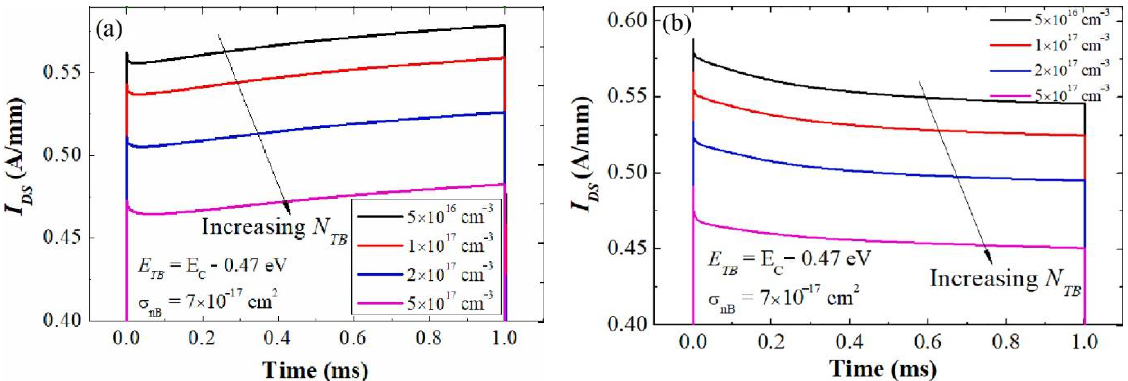
Figure 36. By varying buffer trap density, transient response of ( a ) gate lag and ( b ) drain lag are observed. Reproduced with permission [163]. Copyright 2021, Elsevier.